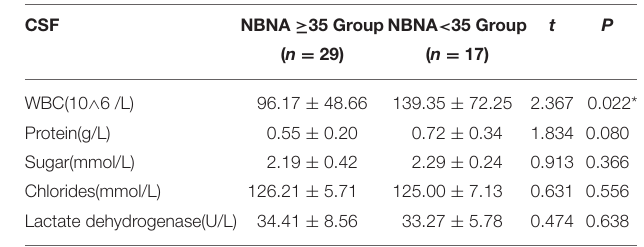
TABLE 2 | Etiological analysis of neonatal HFMD complicated with encephalitis. Group